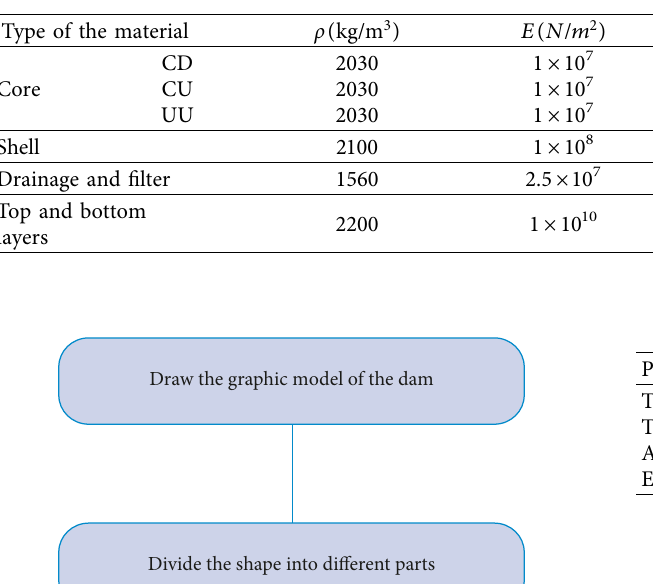
Table 3: Characteristic values of SattarKhan Dam materials.